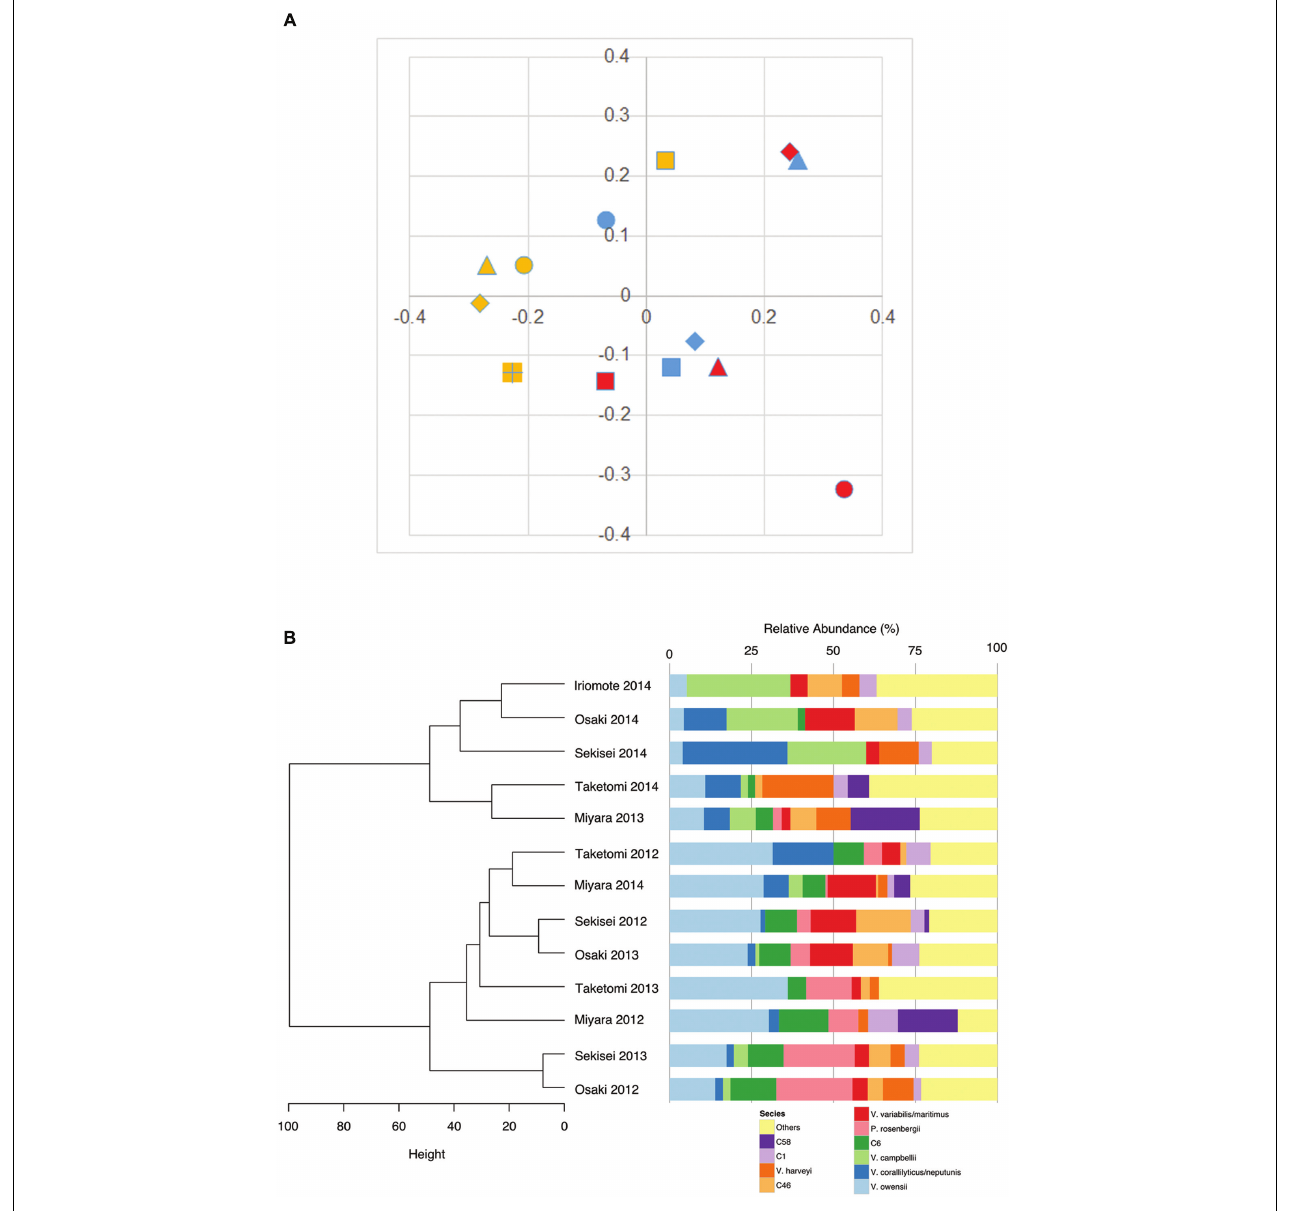
FIGURE 3 | Vibrio community diversity dynamics in Ishigaki coral reef seawater. (A) Multidimensional scaling plot (FastUnifrac:PCoA), isolates indicating colors and shapes: blue, 2012; red, 2013; yellow, 2014; dot, Taketomi; square, Miyara; diamond, Osaki; triangle, Sekisei; square ( + ), Iriomote; (B) dendrogram clustering of vibrios according to their relative